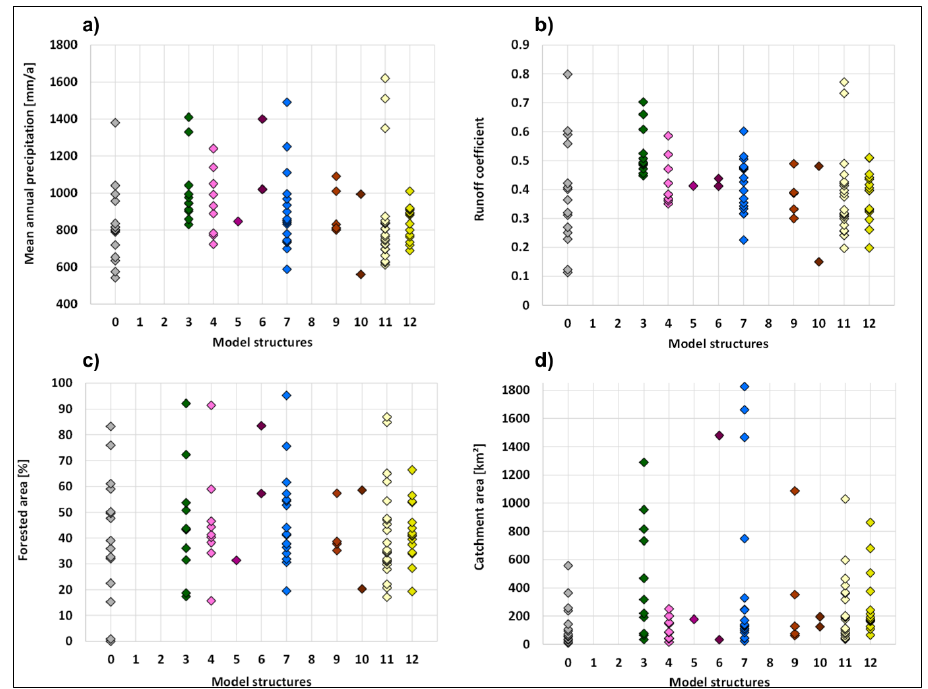
Figure 9. Catchment characteristics of catchments sorted by the best performing model structures M01 to M12 and catchments without an acceptable model (“Model structure” 0): ( a ) mean annual precipitation; ( b ) mean runoff coefficient; ( c ) percentage of forested area; and ( d ) catchment size.